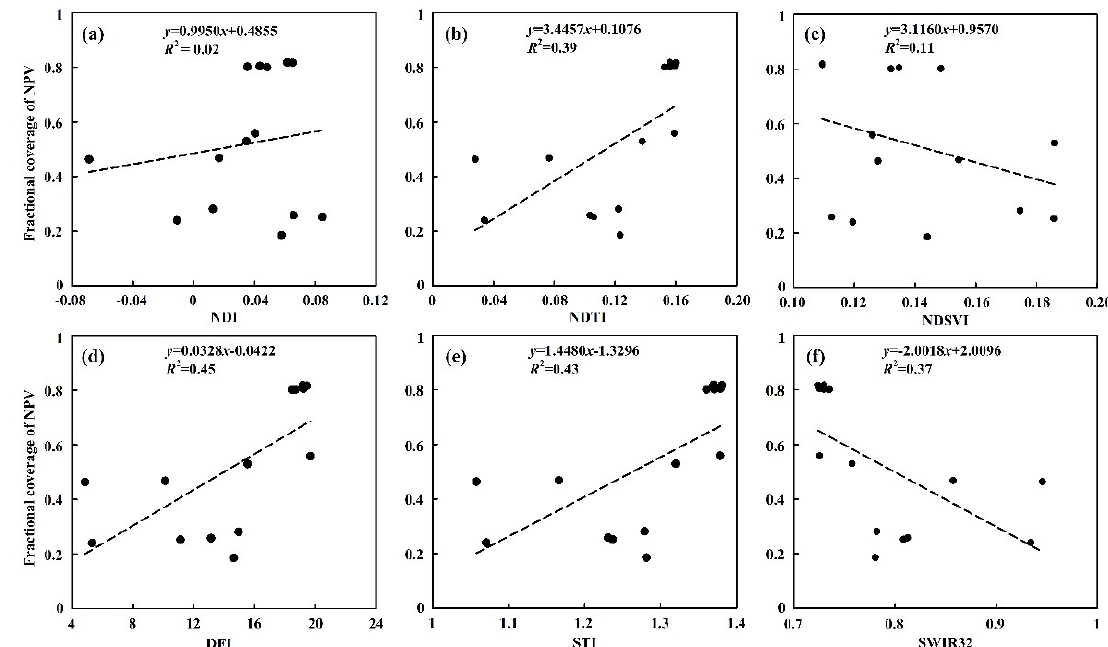
Figure 6. Linear regression between different NPVIs and the f NPV . The NPVIs are ( a ) NDI, ( b ) NDTI, ( c ) NDSVI, ( d ) DFI, ( e ) STI and ( f ) SWIR32, respectively.